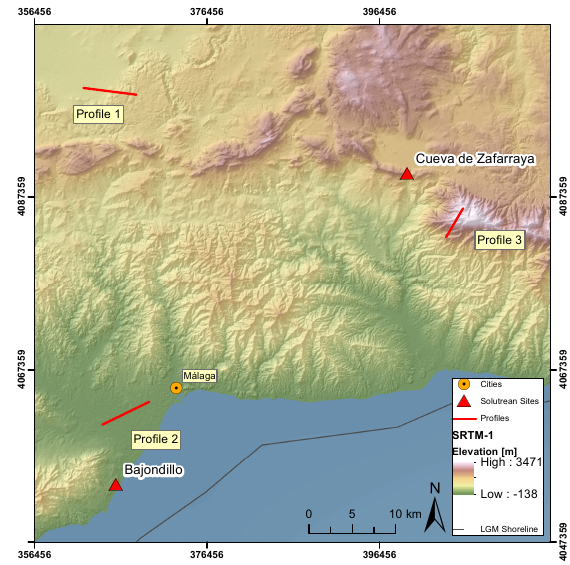
Figure 3. Sample elevation profiles in Andalusia.